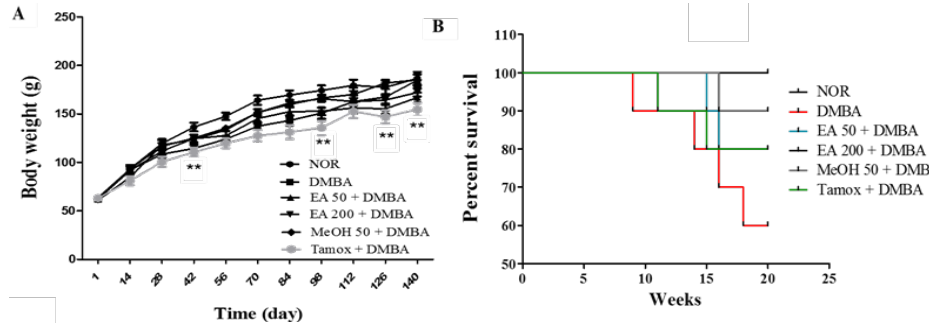
Figure 9. Effects on animal body weight and survival. Body weight ( A ) and Kaplan Meir survival curve ( B ) after 20 weeks of treatment. NOR, Normal control treated with 2% ethanol; DMBA, DMBA control treated with 2% ethanol; EA + DMBA, Animals treated with the F. umbellata aqueous extract at the doses of 50 mg/kg and 200 mg/kg. MeOH + DMBA, Animals treated with the F. umbellata methanol extract at the dose of 50 mg/kg. TAM + DMBA, Animals treated with tamoxifen (3.3 mg/kg); All groups except of normal group (NOR) received an intragastric dose of DMBA at the dose of 50 mg/kg followed by a 10-day subcutaneous administration of 17β-estradiol (5 mg/kg). Data are represented as mean ± SEM ( n = 10). ** p < 0.01 as compared to negative control.